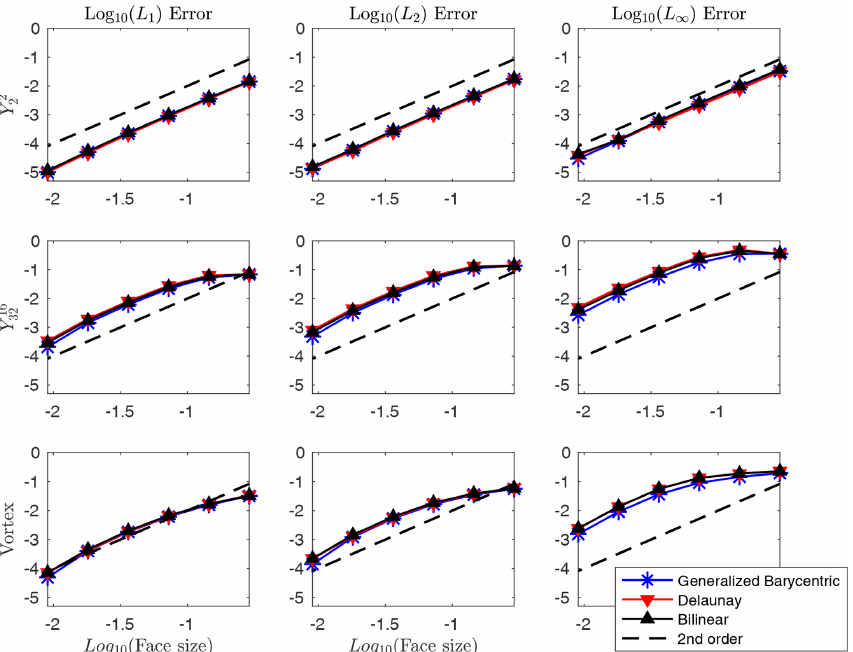
Figure 11. Convergence results for several non-integrated monotone remapping schemes for a fixed latitude–longitude target mesh and triangular source